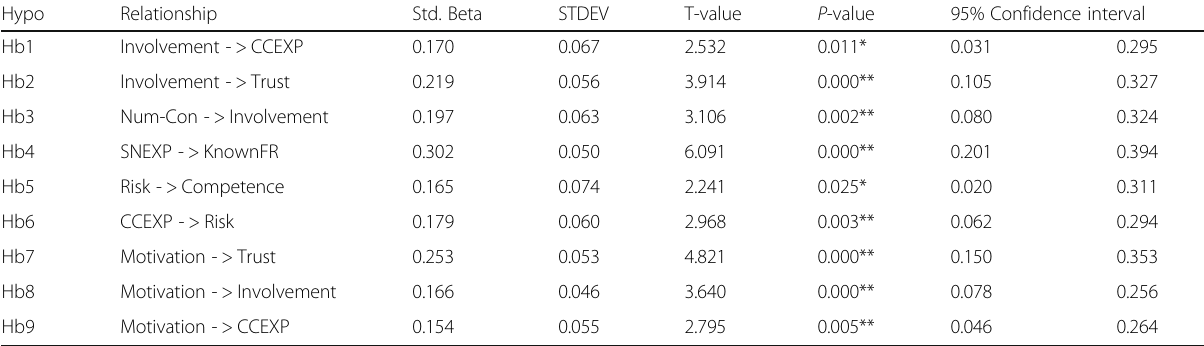
Table 7 Path coefficient results (significance testing- group b)